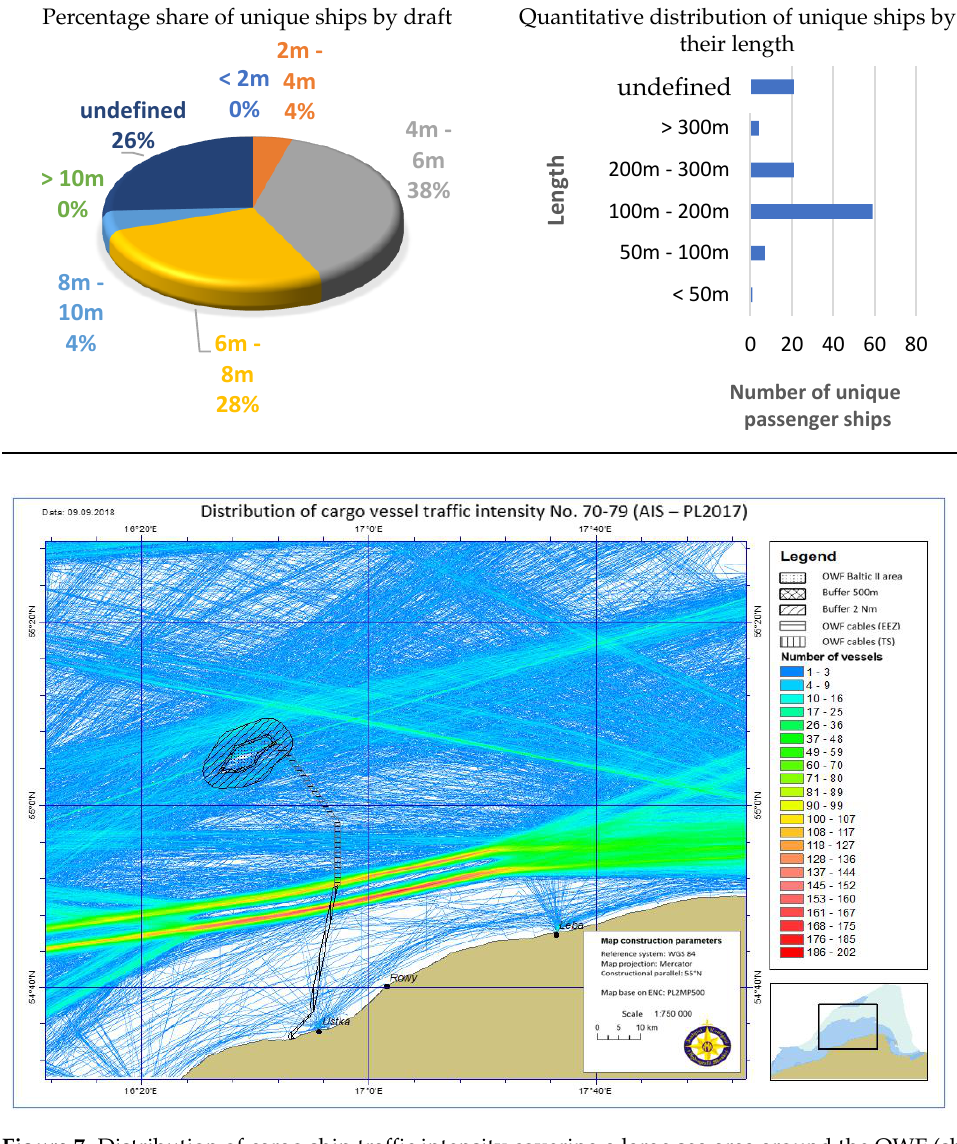
Figure 7. Distribution of cargo ship traffic intensity covering a large sea area around the OWF (ship type numbers: 70 – 79, AIS-PL 2017).